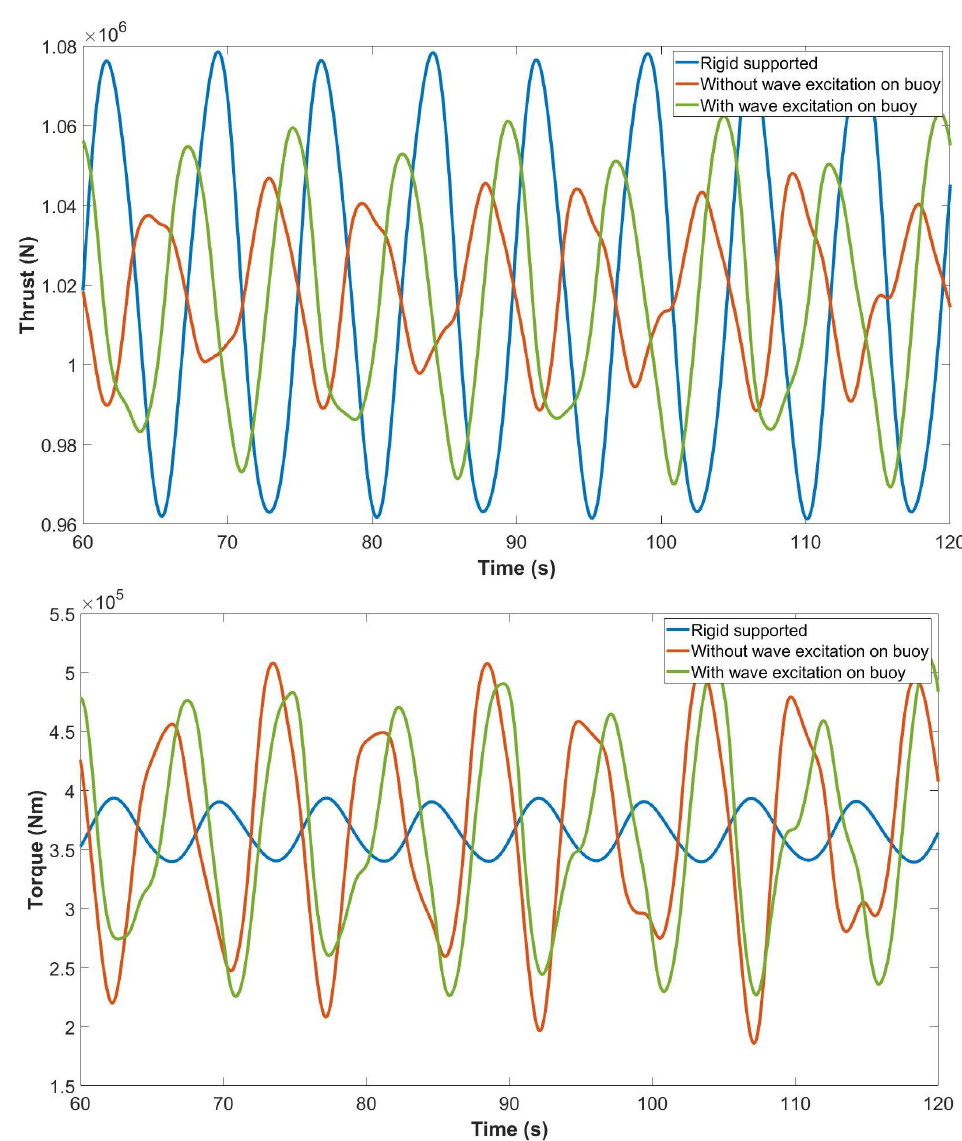
Figure 7. Thrust and torque in sea state